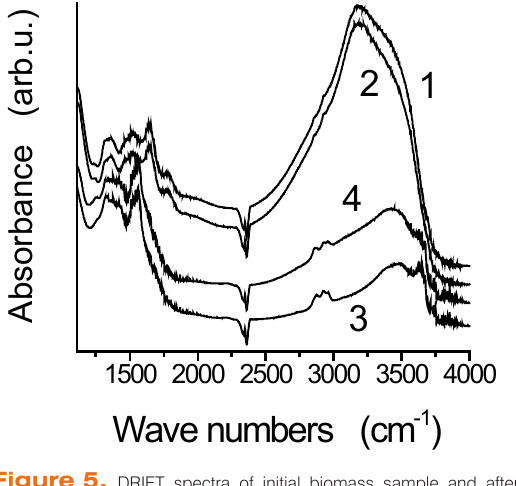
Figure 5. DRIFT spectra of initial biomass sample and after its treatment in Ar flow: 1 – initial biomass sample; 2 – in Ar flow at room temperature; 3 – in Ar flow at 250°C; 4 – after cooling down in Ar